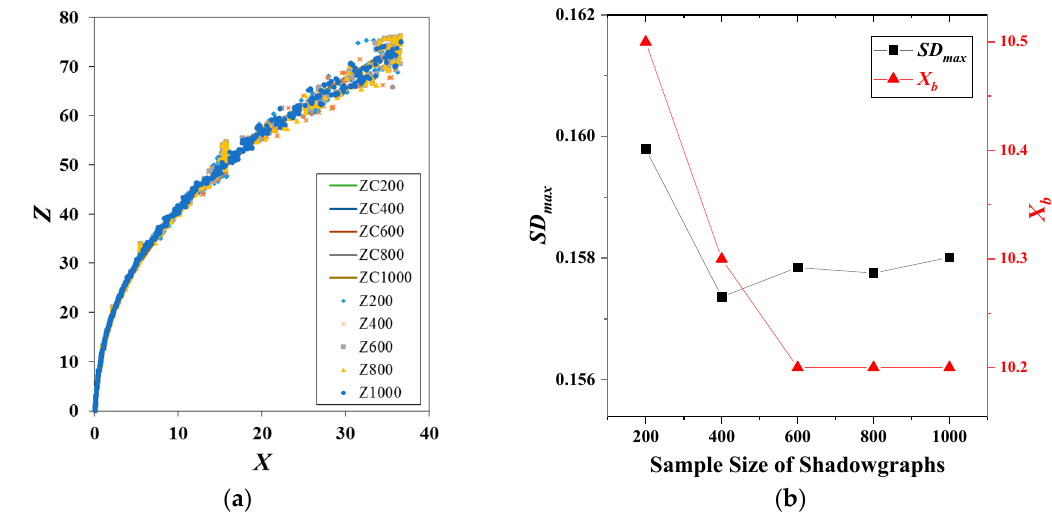
Figure 7. E ff ects of the sample size of the shadowgraphs on the processing results: ( a ) Jet boundary; ( b ) Liquid-column fracture location X b and maximum grayscale